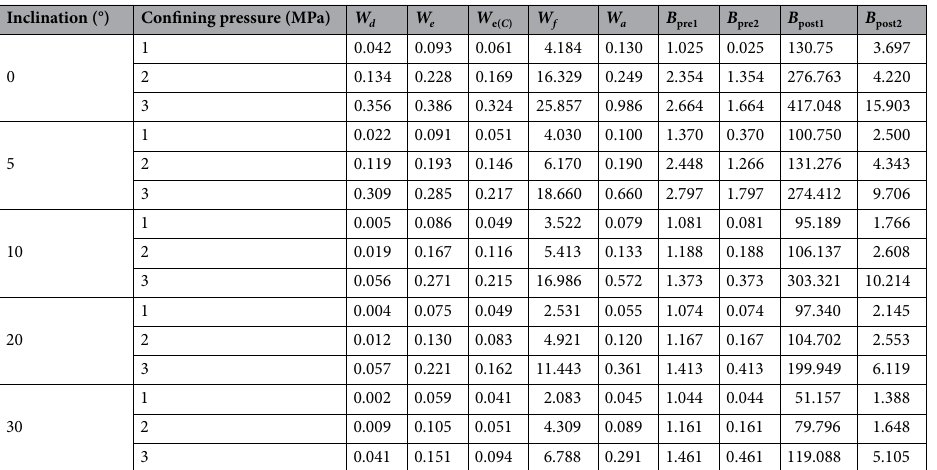
Table 2. Different energy and index statistics